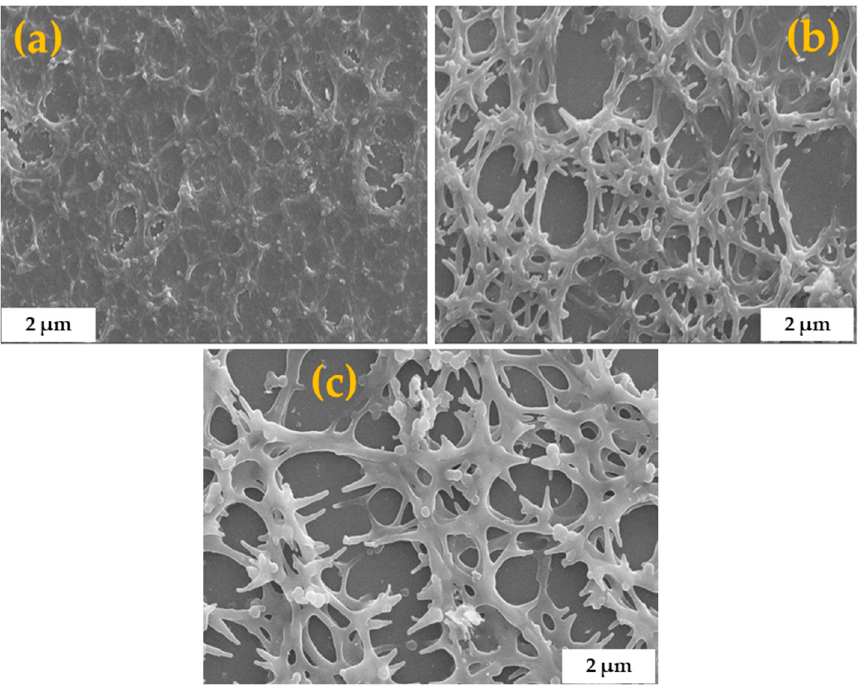
Figure 8. SEM morphologies of C-N-TiO 2 coated on support at a sol gel-solvent ratio varied from 3:5 ( a ), 4:5 ( b ), to 5:5 ( c ), and constant spinning speed of 2600 rpm for 90 s followed by pyrolysis at 350 °C in N 2 (ramping rate of 10 °C /min) for 105 min. Table 5. Weight percentages of elements C, Ti, and O in the films coated at different sol gel-solvent ratio ( V : V ) at a constant speed (2600 rpm) and coating time of 90 s followed by annealing at 350 °C, at a ramping rate of 10 °C /min for 105 min. Elemental composition (wt %) of uncoated and C-N-TiO 2 -coated films.